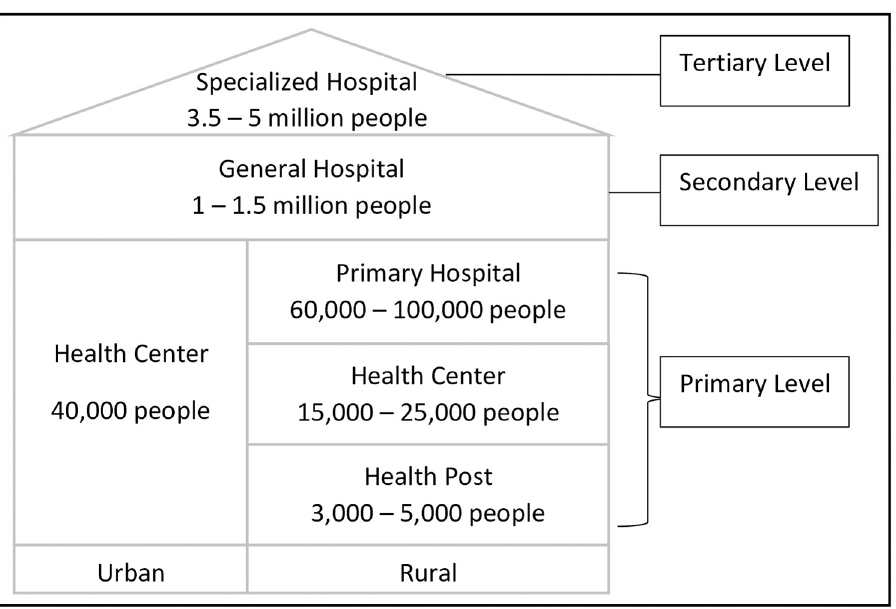
Fig 1. Ethiopian healthcare tier system (source: Health sector development program IV [14])–this diagram is for any illness, not specific for mental illness.